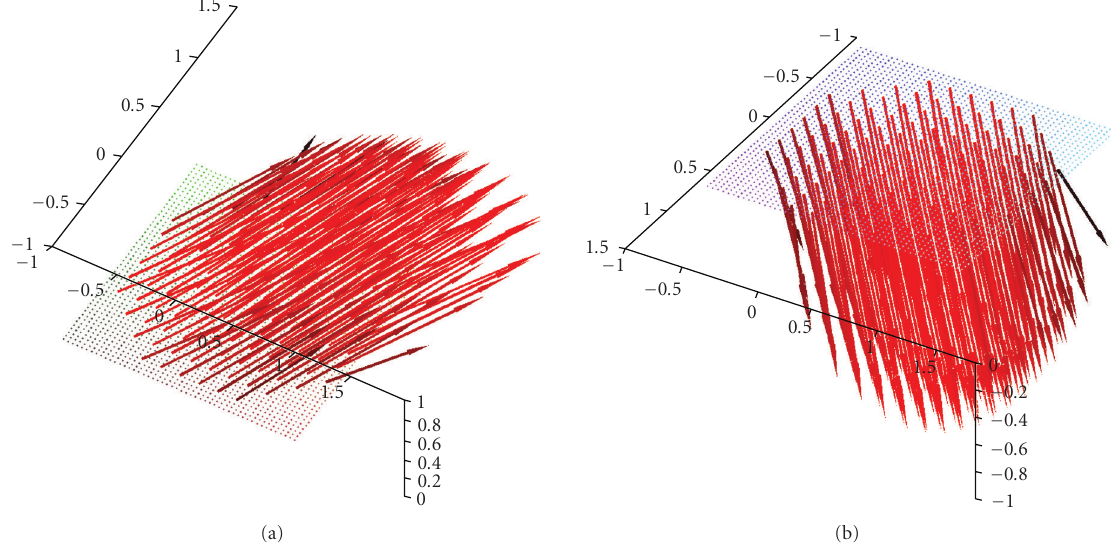
Figure 17: (a) Reconstruction of the vector field f ( x ) = (1,1,1) (cid:9) with the described algorithm for γ = 0 . 007 with circles in the planes { x = 0 } and { x = 0 } . (b) Reconstruction of the vector field f ( x ) = (1,1, − 1) (cid:9) with the described algorithm for γ = 0 . 007 with circles in 3 1 the planes { x 3 = 0 } and { x 1 = 0 }